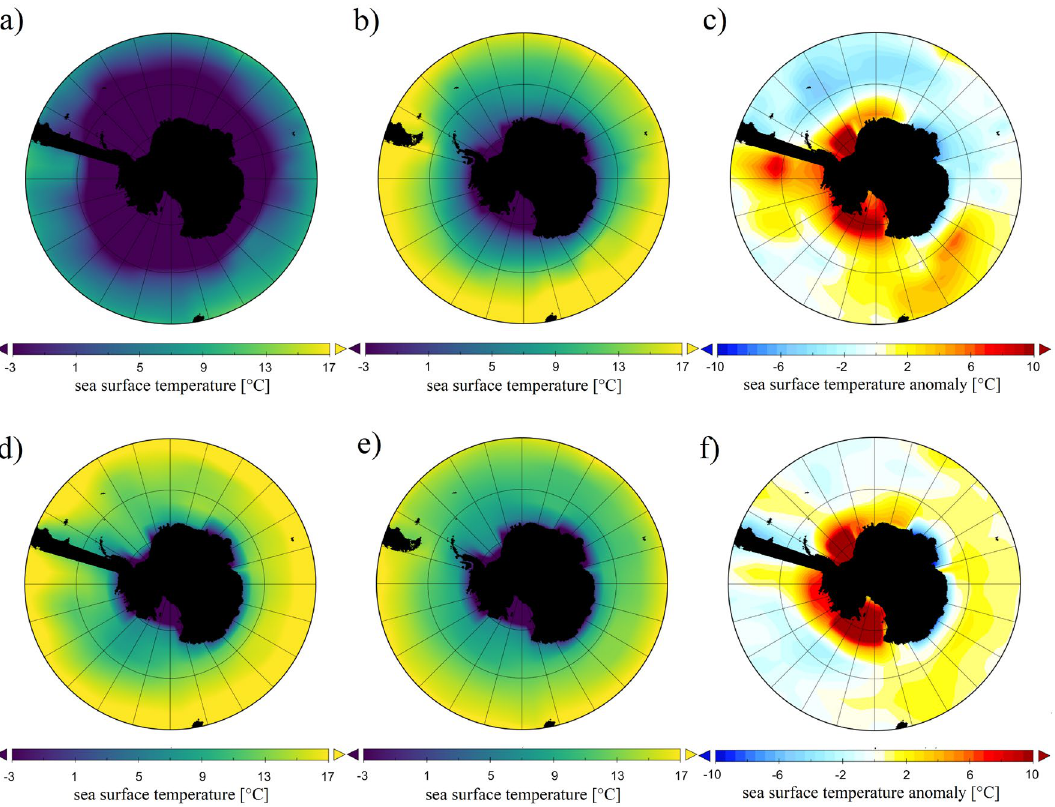
Figure 5. Mean surface temperature fields from the GCM: for “ice OFF” closed ( a ), open ( b ), closed “anomaly” ( c ) cases, and “ice ON” closed ( d ), open ( e ), closed “anomaly” ( f ) cases. “Closed anomaly” here (panels c and f ) means that the 200-year zonal averages are subtracted from the “closed” maps. The figure was created using Panoply 4 developed at the NASA Goddard Institute for Space Studies (freely available and downloadable at https:// www. giss. nasa. gov/ tools/ panop